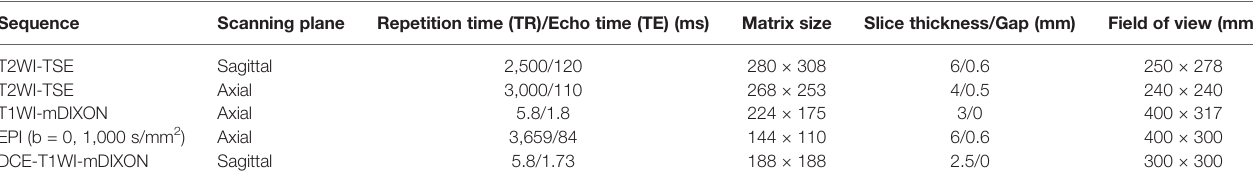
TABLE 1 | MRI protocol: sequences and parameters.